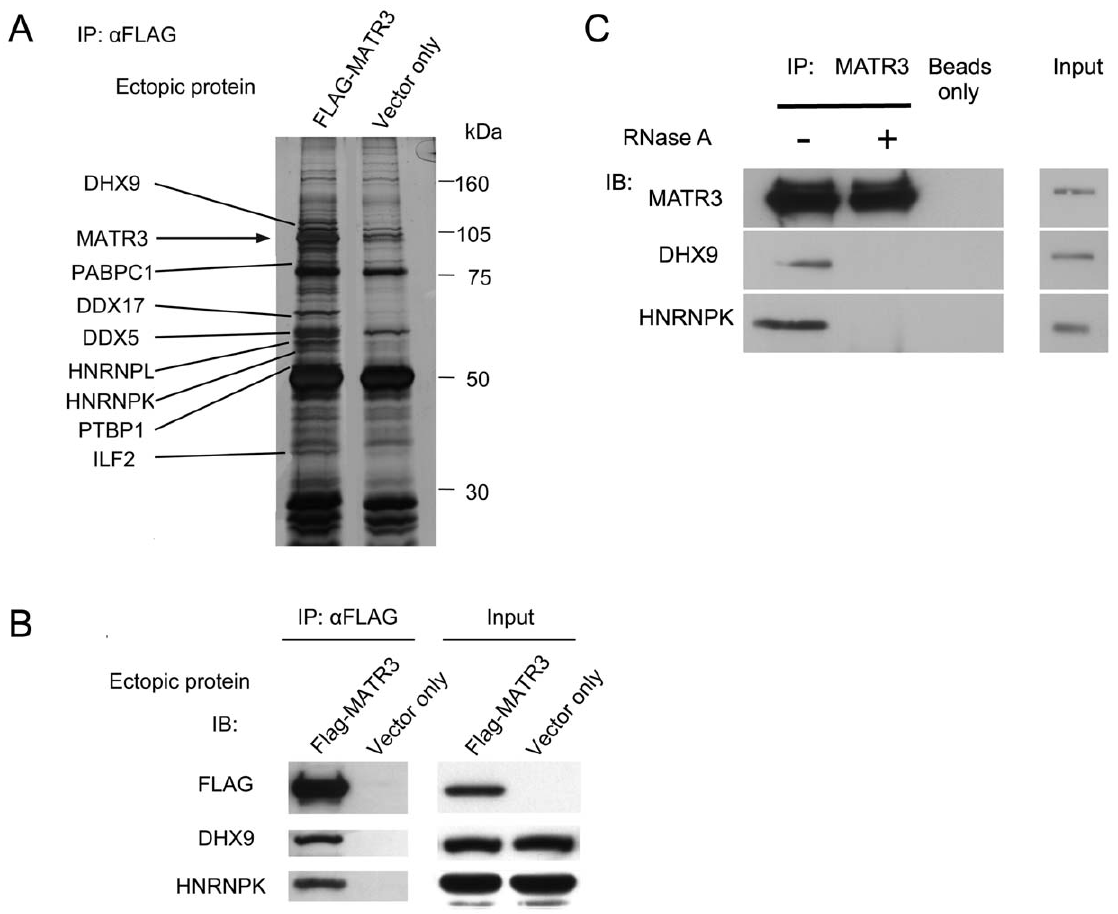
Figure 1. Identification of novel MATR3 interactors. ( A ) FLAG-MATR3 was expressed in HEK293T cells and immunoprecipitated using anti- FLAG conjugated beads. Immune complexes were separated by SDS-PAGE and visualized with silver staining. Cells with empty vector allowed discrimination between specific and non-specific immunoprecipitation. Bands that appeared specific were identified using mass spectrometry. ( B ) FLAG-MATR3 was expressed in HEK293T cells and immunoprecipitated using FLAG-conjugated beads. The immune complexes were blotted with the indicated antibodies. ( C ) Endogenous MATR3 was immunoprecipitated from HEK293T cells, and the immune complexes were treated with RNase A and blotted with antibodies against the indicated proteins.